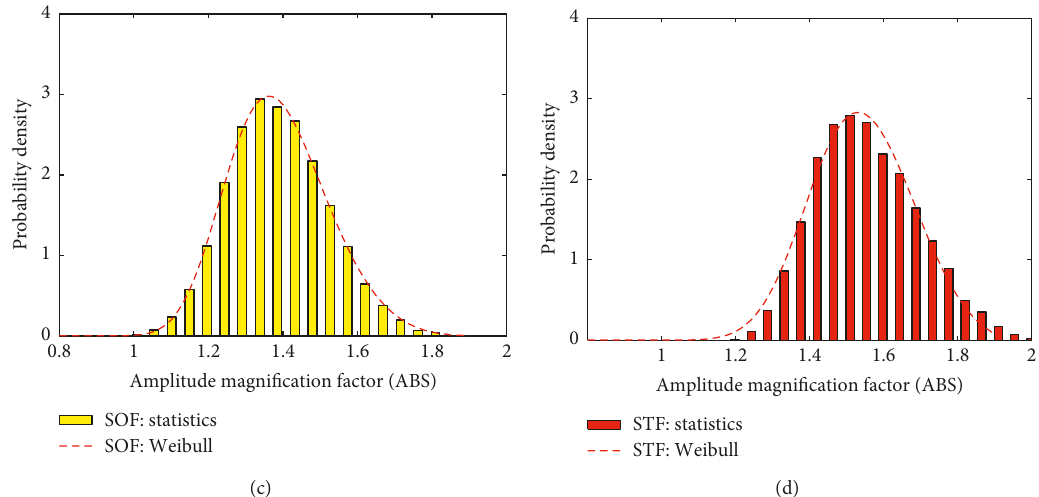
Figure 14: Probability densities versus absolute AMF obtained by Monte Carlo simulation of 10000 mistuning patterns generated by uniform distribution of mean 0 and standard deviation 2.0%: (a) case STA, (b) case COR, (c) case SOF, and (d) case